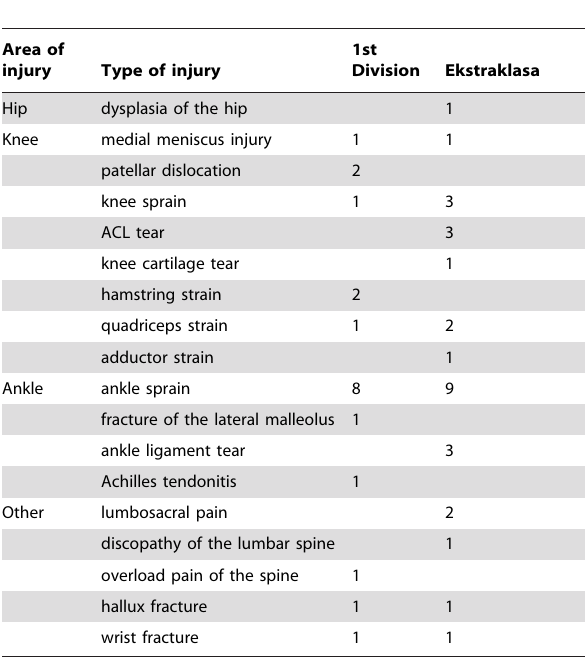
Table 2. Number of players reporting